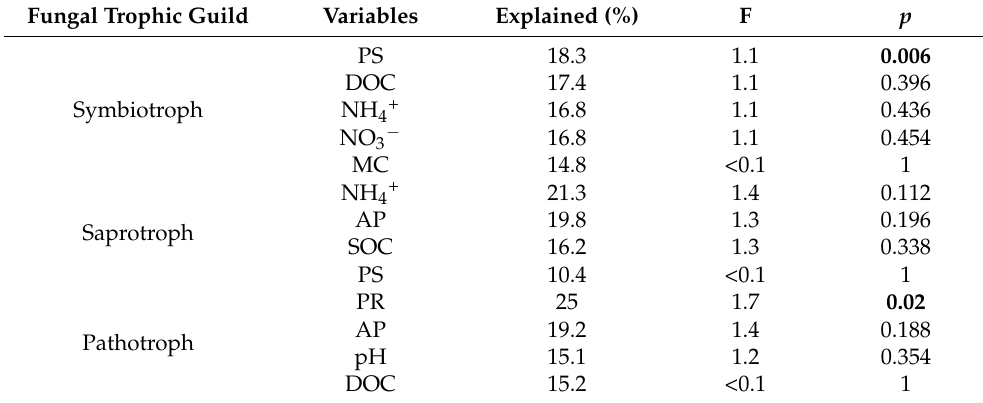
Table 7. Canonical correlation analysis (CCA) between environmental factors and the